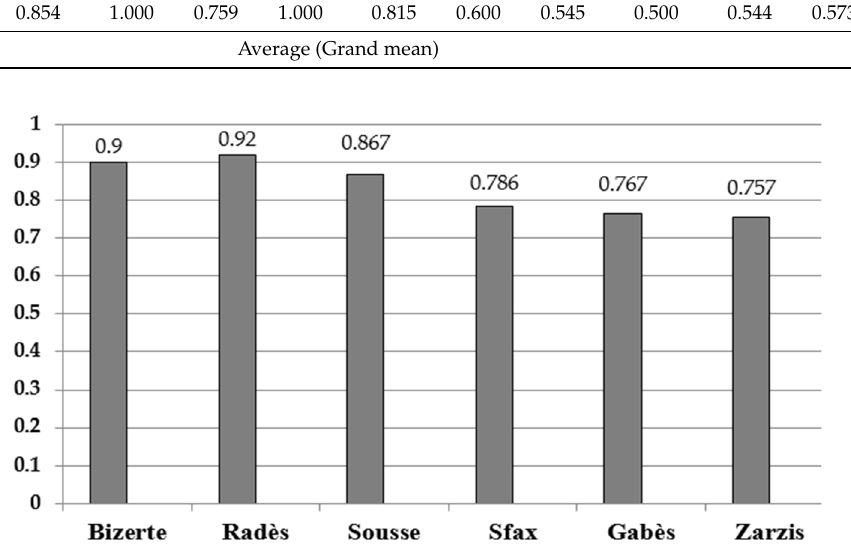
Figure 3. Pure technical efficiency (DEA-BCC) of the Tunisian ports (2005–2016).